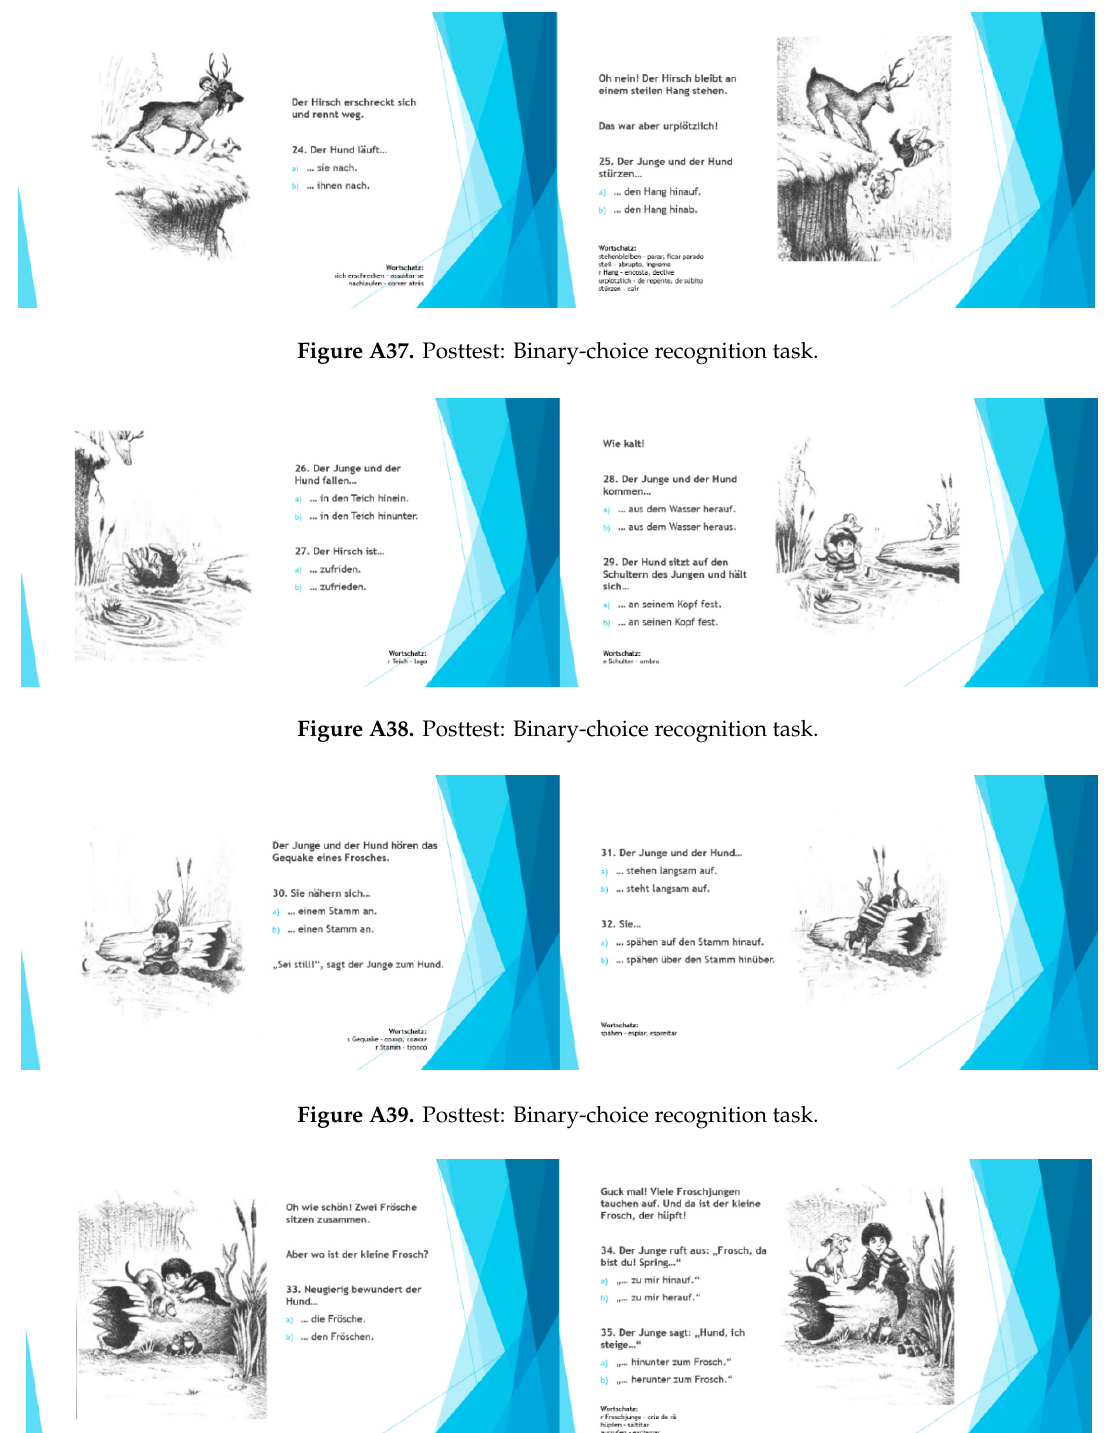
Figure A40. Posttest: Binary-choice recognition task.